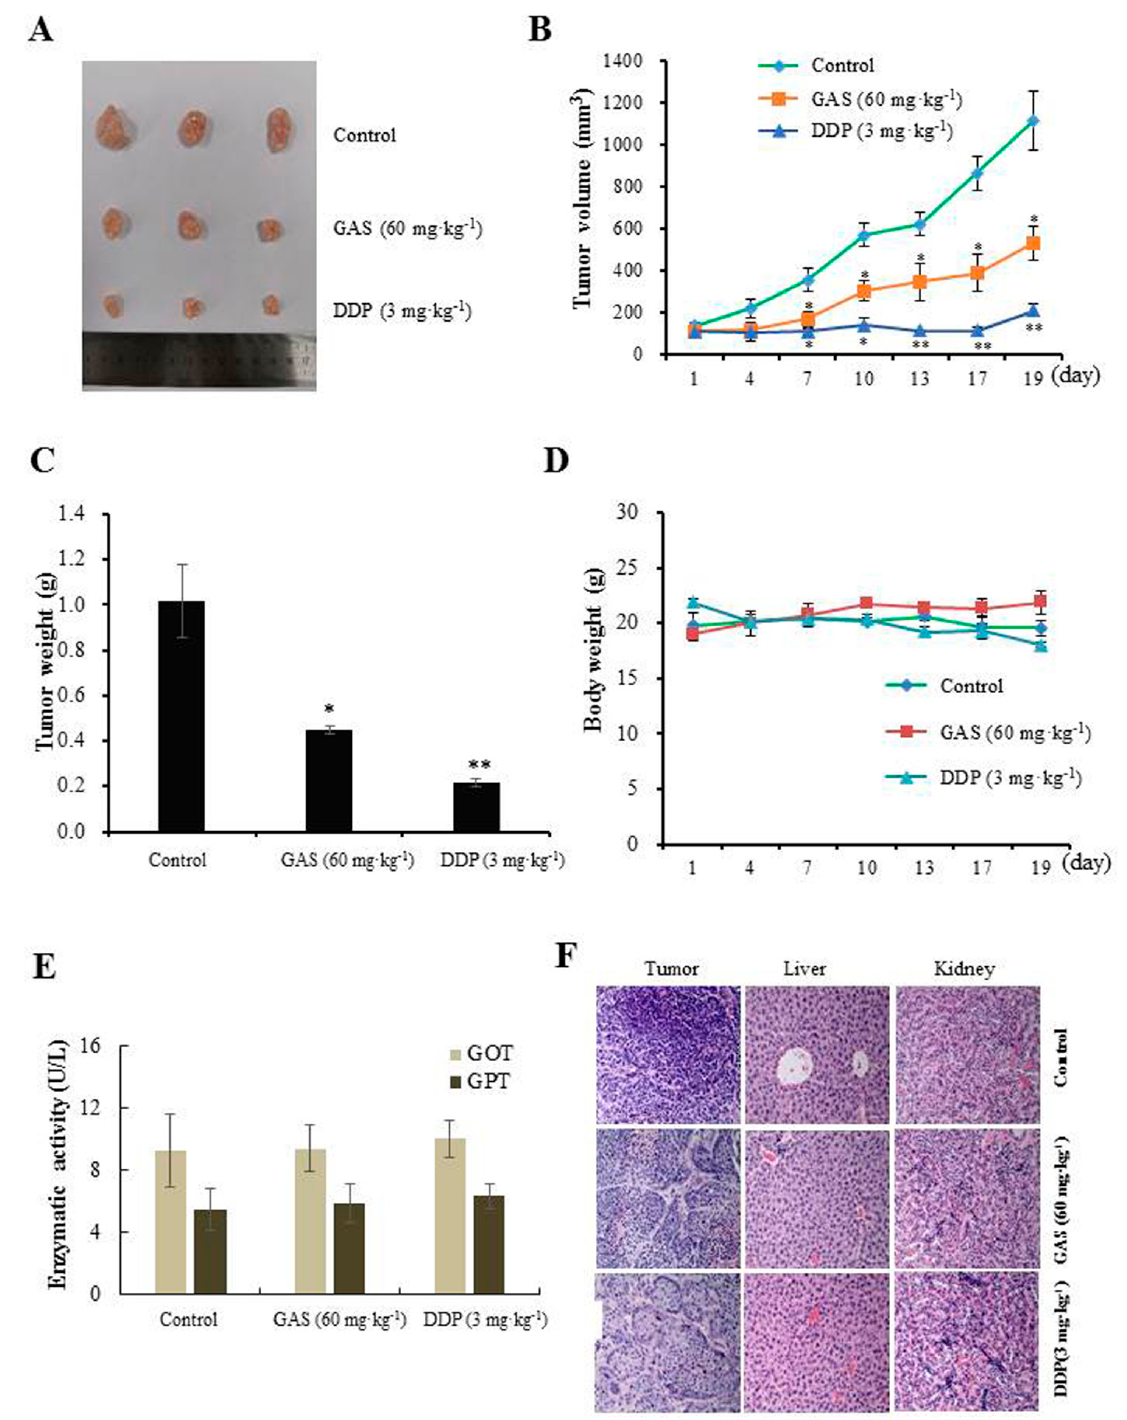
Figure 2. Anti-tumor efficacy of GAS on CNE-2Z cells xenograft in nude mice ( n = 3). ( A ) Representative images of subcutaneous xenograft tumors from each treatment group. ( B ) Measurements of tumor volume. ( C ) Measurements of tumor weight after treatment for 19 days. ( D ) Body weight of mice. ( E ) Serum GOT and GPT levels as determined using an assay kit. ( F ) H&E staining of tumors, livers, and kidneys from mice after treatment (magnification: 200×). * p < 0.05 and ** p < 0.01 compared to the control.